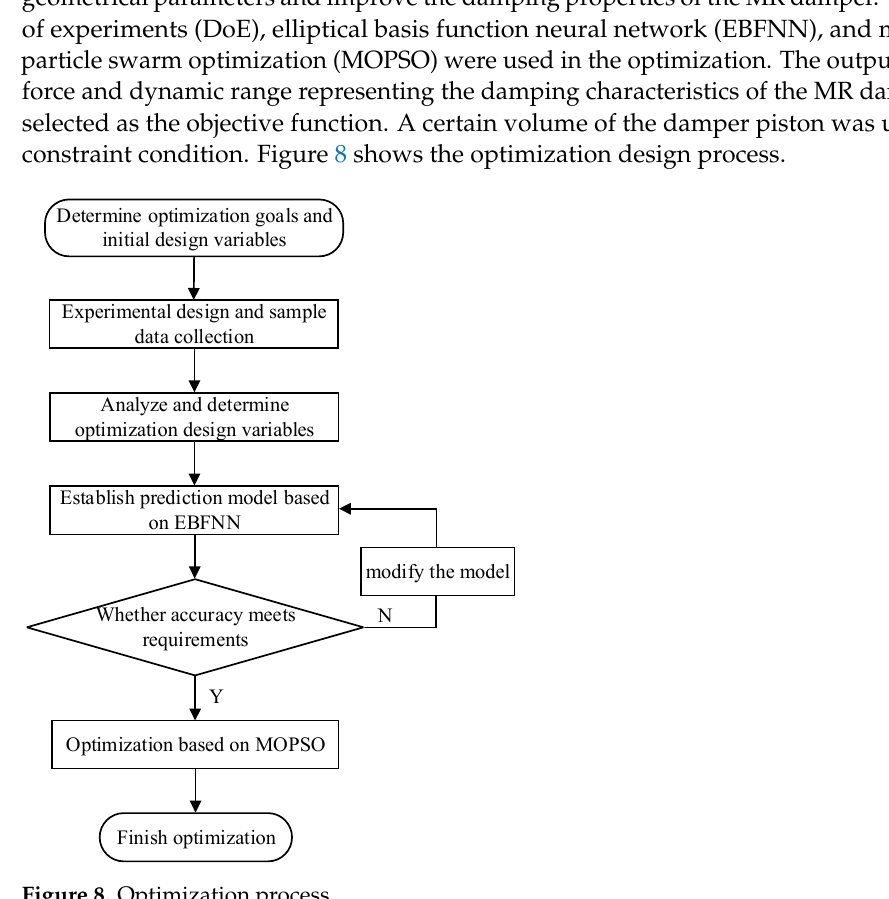
Figure 8. Optimization process.